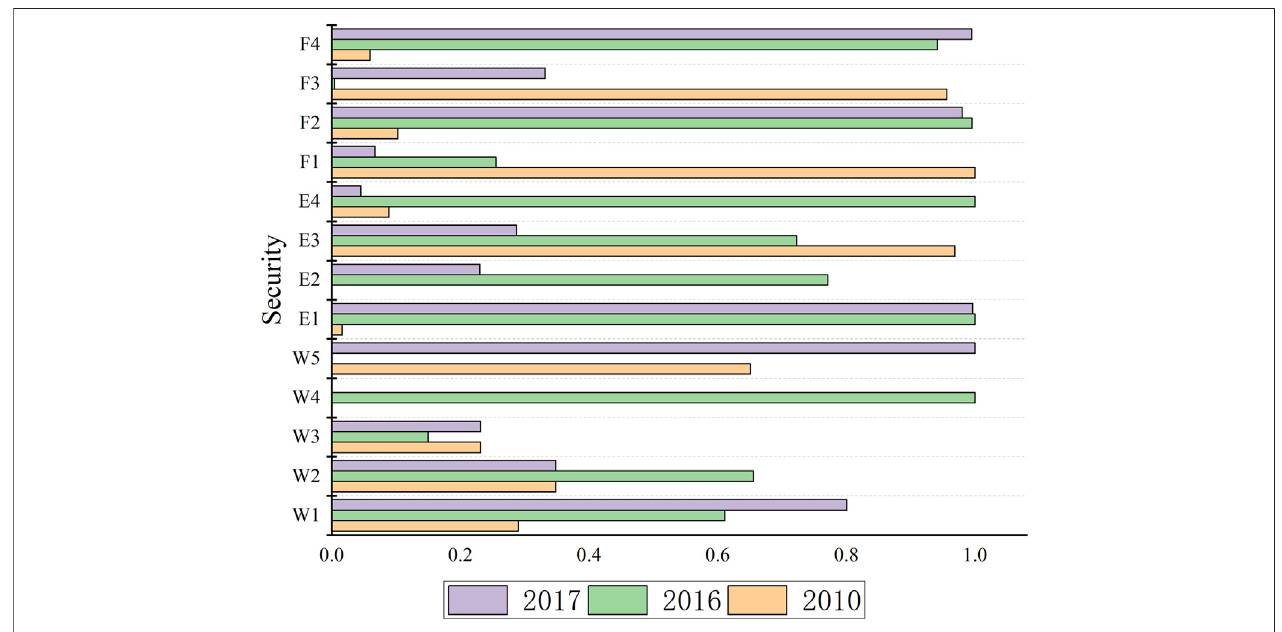
FIGURE 5 | Comparison of security indicator evaluation values in typical years.